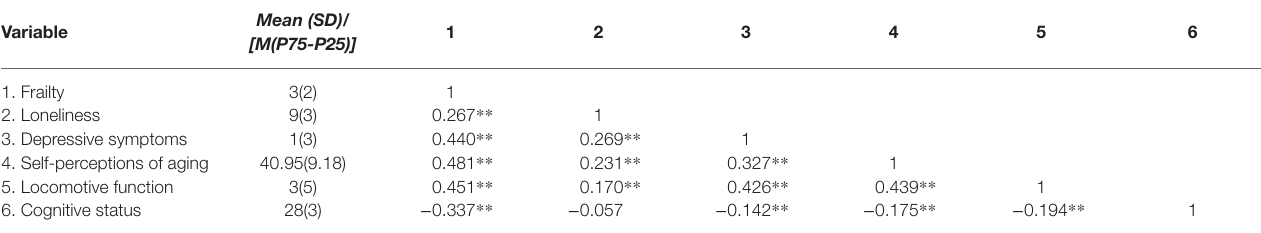
TABLE 2 | Spearman correlations for loneliness, depressive symptoms, self-perceptions of aging, locomotive function, cognitive status, and frailty. Variable